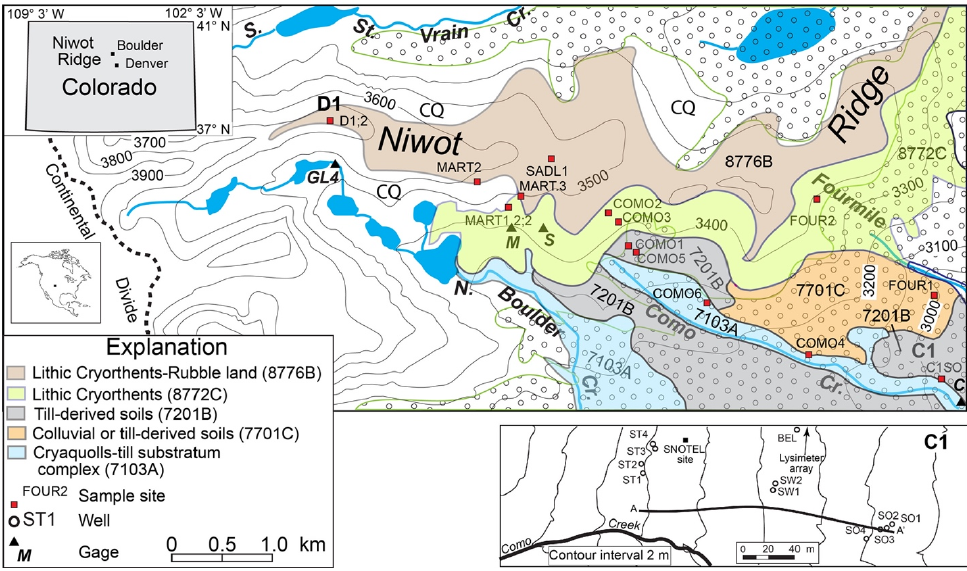
Figure 2. Map showing location of Colorado, Niwot Ridge and sites noted in the text. Sampled soils were mapped by the NRCS [16] and include areas of CQ (cirque deposits). Stipple shows extent of forested area. Inset shows detail of sample sites at C1 and location of Como Creek and cross-section A–A’. Several flood channels are located between Como Creek and the cross-section. Soil mapping not shown south and west of N. Boulder Creek.